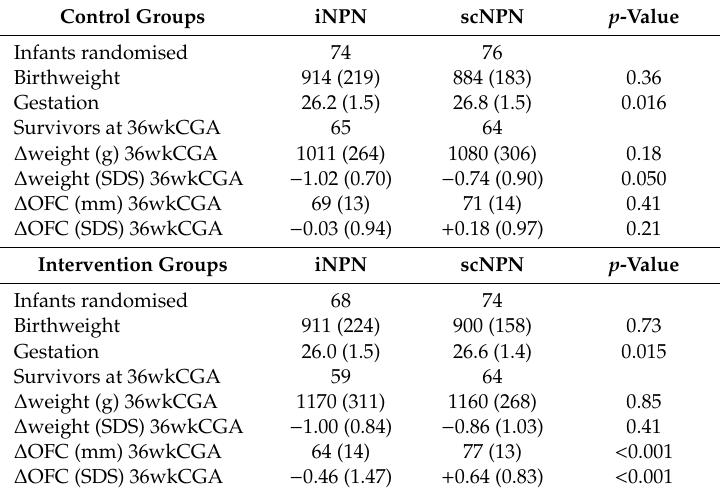
Table 2. Growth data comparing change in weight ( ∆ weight; g or standard deviation score; SDS) and change in head circumference ( ∆ OFC; mm or standard deviation score; SDS) between birth and 36 weeks corrected gestational age (36wkCGA) in control iNPN and scNPN groups and intervention iNPN and scNPN groups.